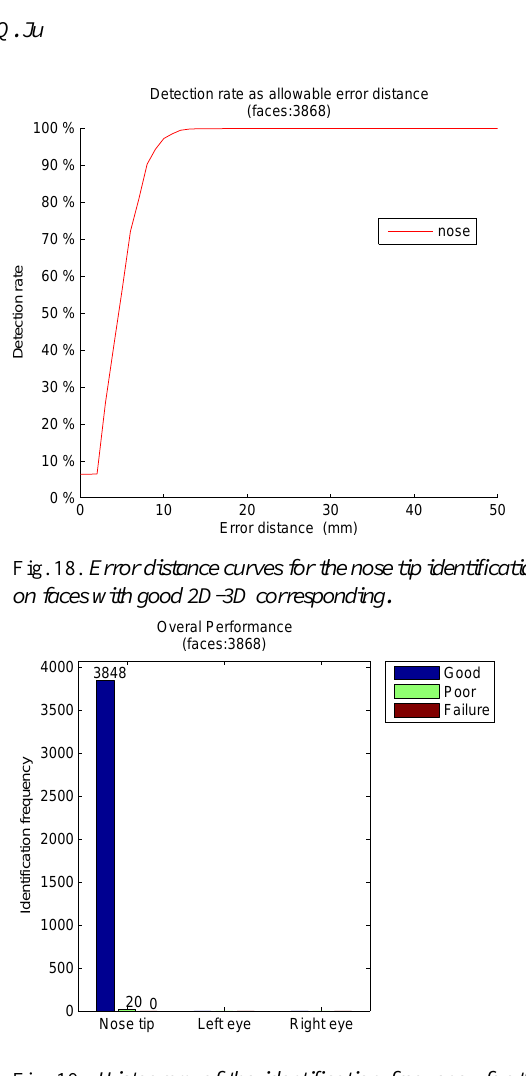
Fig. 19. Histogram of the identification frequency for the nose tip identification on faces with good 2D-3D corre- sponding.